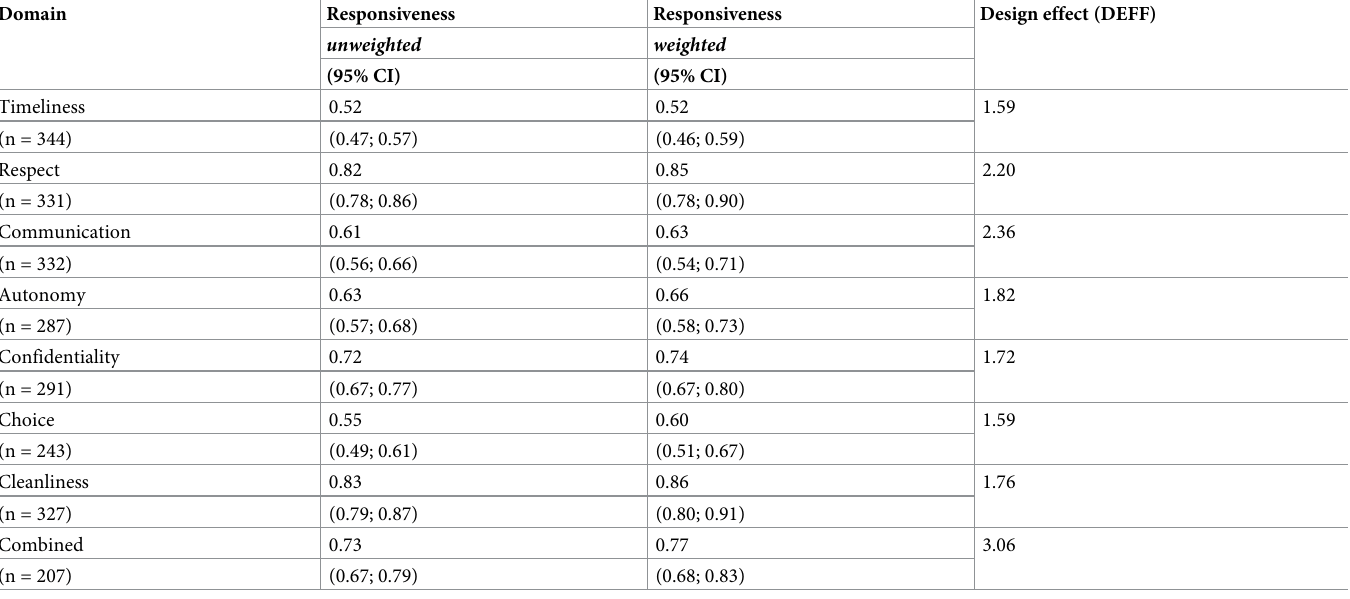
Table 3. Weighted and unweighted responsiveness results by domain, with 95% confidence intervals and overall design